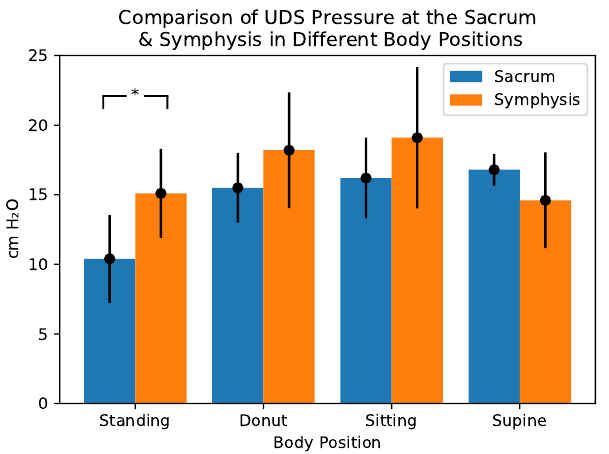
Figure 3. Comparison of the different pressures exerted on the pelvic floor in the different positions in the anterior vs. the posterior compartments (anterior being the symphisis region while posterior being the sacral region). Asterisks indicate statistically significant values.